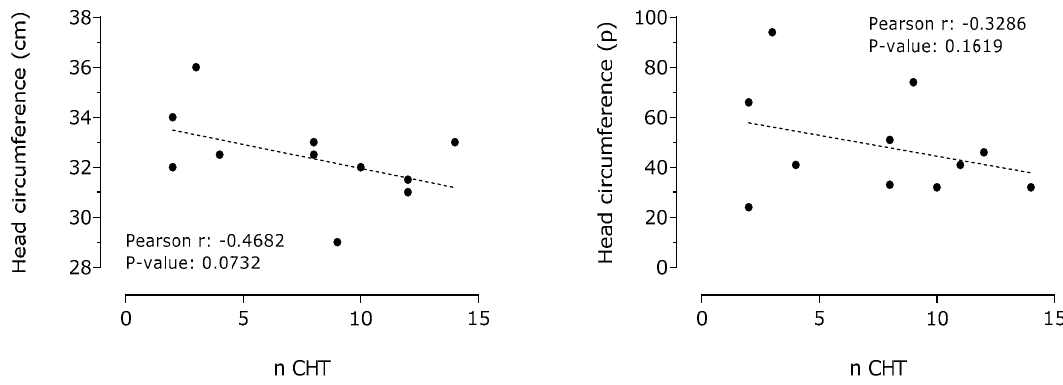
Figure 6. Correlation between number of chemotherapy cycles administered (n CHT) and neonate head circumference or percentile in pregnant women affected by breast cancer ( n = 12).